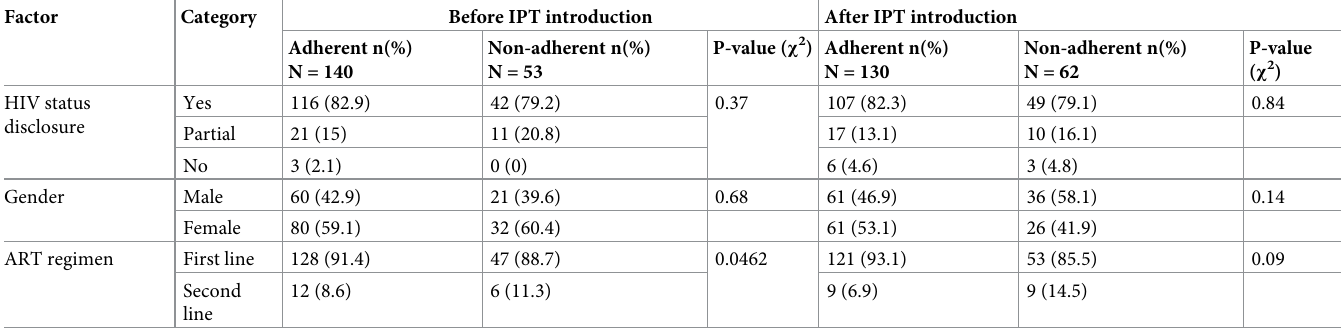
Table 3. Bivariate analysis of factors associated with ART adherence before and after added pill burden (IPT introduction). Factor Category